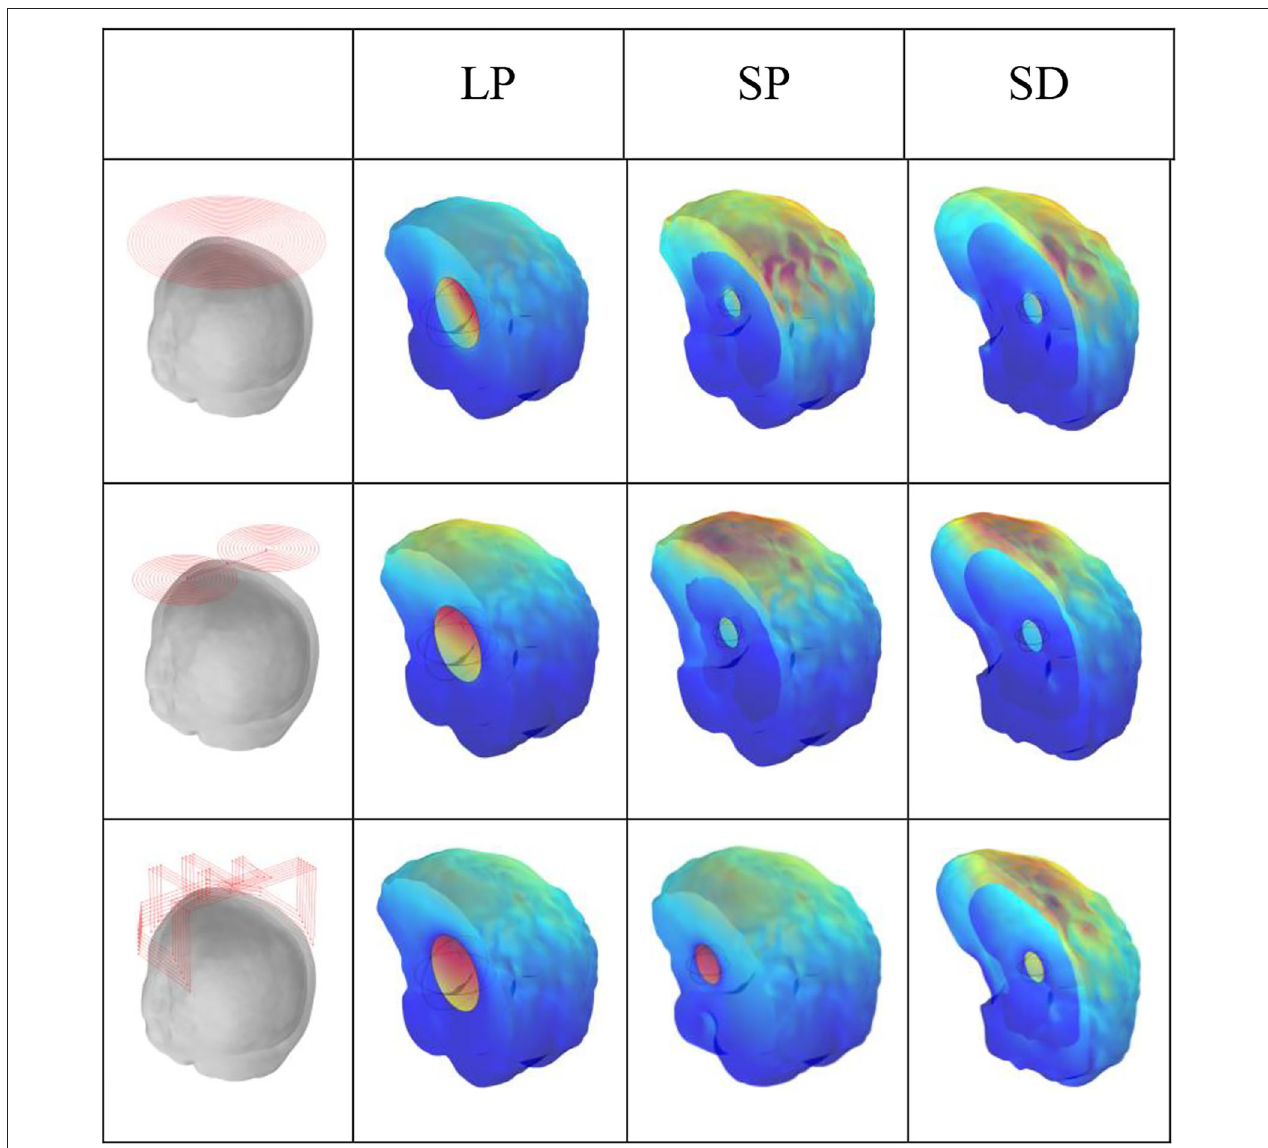
FIGURE 8 | Current density of cerebral haemorrhagic